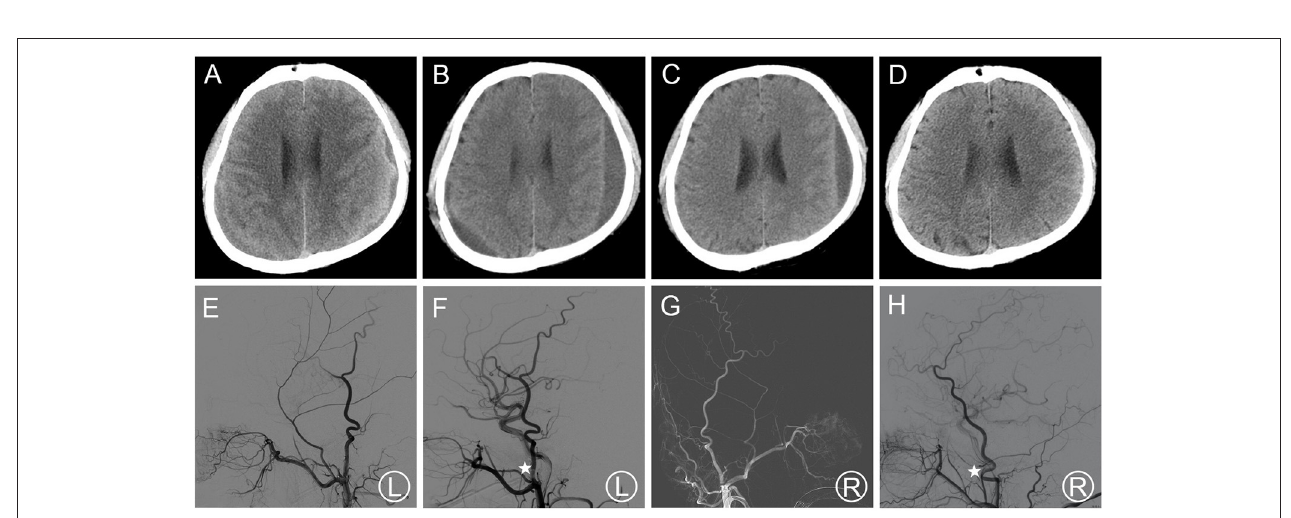
FIGURE 2 | (A) Brain CT images of a hematoma in patient 2 before treatment. (B,C) Brain CT was repeated at 14 days after surgery and before the patient’s discharge. (D) Follow-up brain CT was performed at 97 days. (E,F) Pre- and post-operative DSA presented left MMA and the left MMA disappeared (asterisk). (G,H) Pre- and post-operative DSA presented right MMA and the right MMA disappeared (asterisk). DSA, digital subtraction angiography; CT, computed tomography; MMA, middle meningeal